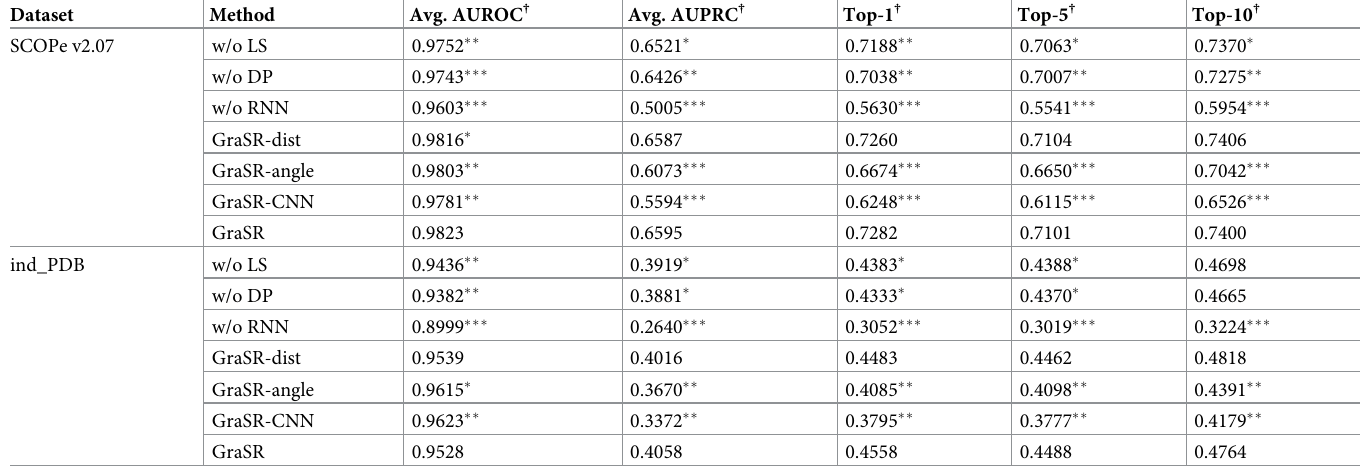
Table 1. Ablation studies of length-scaling cosine distance, the dynamic training data partition strategy and the GNN-based encoder on SCOPe v2.07 and ind_PDB.